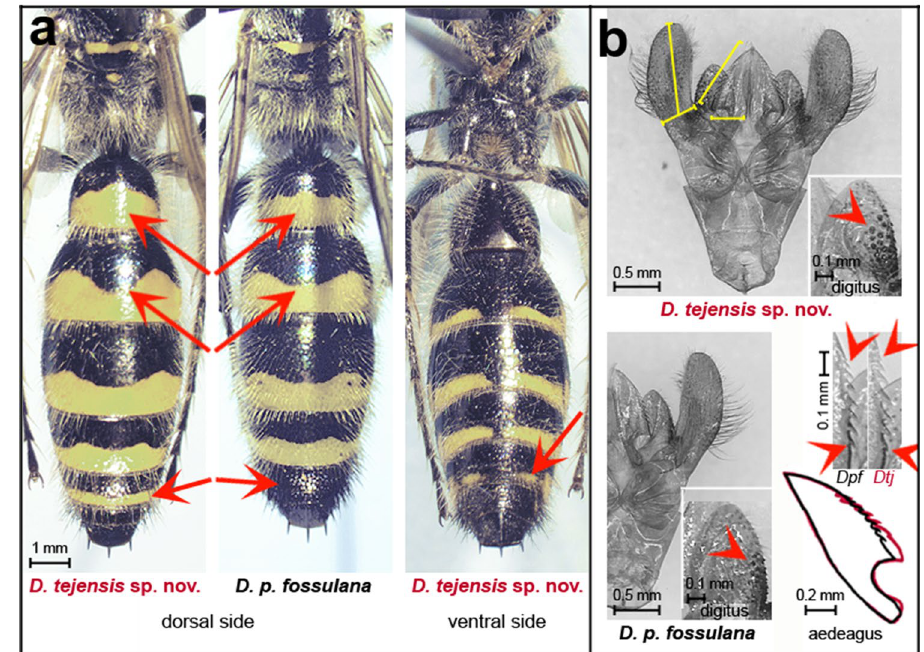
Figure 2. Selected phenotypic characters distinguishing D. tejensis sp. nov. ( Dtj ) from the most closely related species D. p. fossulana ( Dpf ). ( a ) Metasoma. ( b ) Dorsal aspect of terminalia (aedeagus blades are spread perpendicular to their natural position); digitus volsellaris in ventral view; serrated margin of the aedeagus; and alignment of the shapes of the aedeagus blades. Yellow lines indicate how the length and width of the paramere and aedeagus blade were measured. Red arrows indicate differences in the colour pattern on the metasoma, arrowheads point at sensory cones on the digitus, and the 1st and last teeth on the edge of the